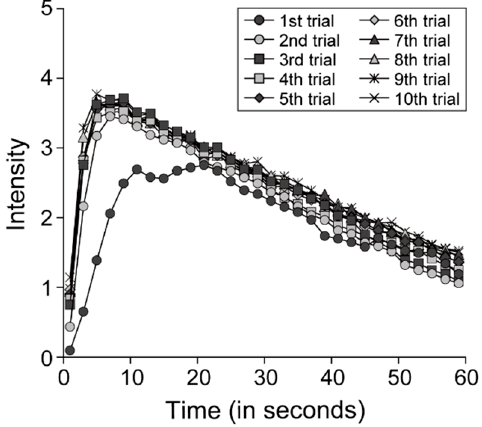
Figure 3. Inter-participant average of TI curves of retronasal aroma.